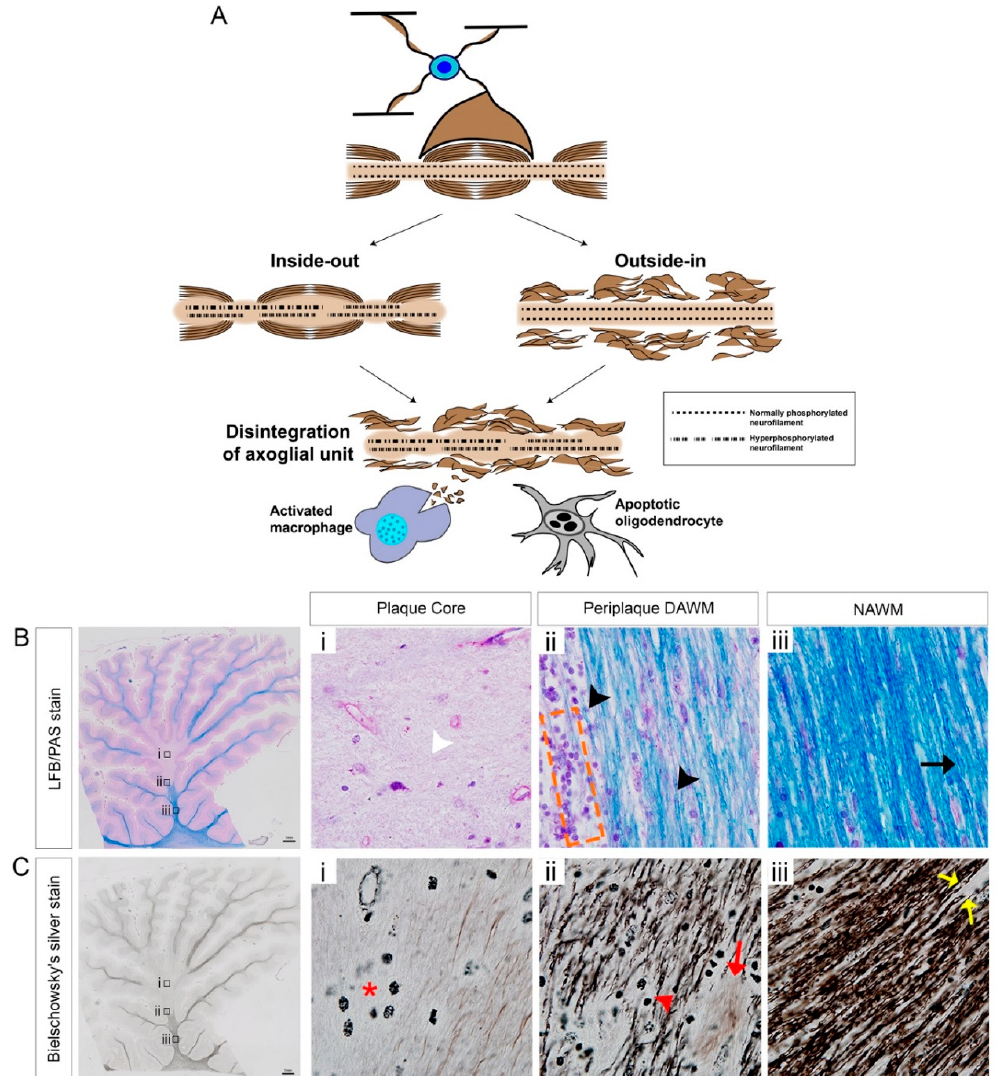
Figure 1. Schematic representation of ‘inside-out’ and ‘outside-in’ models which may govern axo-glial disintegration, leading to accumulated myelin debris in chronic-active MS lesions. ( A ) Myelinated axons are supported by healthy oligodendrocytes and consist of normally phosphorylated neurofilaments for appropriate neuronal architecture. The ‘inside-out’ paradigm (on the left-hand side) is exhibited as a primary axonal degeneration along with hyperphosphorylated neurofilaments with an intact myelin sheath, whereas the ‘outside-in’ paradigm (on the right-hand side) is characterized as the primary demyelination with intact axons. Both paradigms can lead to axo-glial disintegration and oligodendrocyte death. Subsequently, activated macrophages and microglia phagocytose the stripped myelin and extracellular myelin debris. ( B ) Luxol fast blue combined with periodic acid Schiff (LFB-PAS) stained chronic-active MS brain lesions from a secondary progressive MS patient; ( B-i ) plaque core center illustrating the hypocellular or paucicellular nature of the lesion (indicated by white arrowhead), ( B-ii ) periplaque dirty-appearing white matter (DAWM) demonstrating the degenerated myelin (indicated by black arrowheads) along with the hypercellular immune infiltrates (orange dashed box), ( B-iii ) normal-appearing white matter (NAWM) demonstrating even myelin LFB/PAS staining (dark blue, indicated by black arrow). ( C ) Bielschowsky silver stained chronic-active MS brain lesion; ( C-i ) plaque core demonstrates axonal dropout and macrophages (indicated by red asterisk) along with occasional dystrophic axons ( C-ii ) periplaque demyelinated active white matter (DAWM) demonstrating retraction bulbs (indicated by red arrowhead) along with transected axons (indicated by red arrow), ( C-iii ) normal-appearing white matter (NAWM) demonstrating transected axons (indicated by yellow arrow). Scale bar = 1